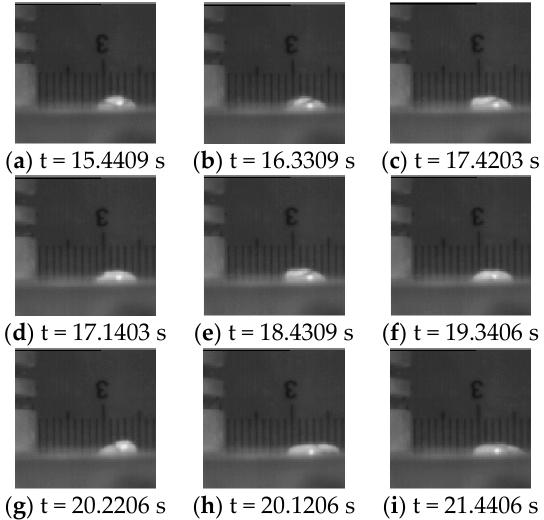
Figure 15. The movement characteristics of droplet under DC positive polar power source. ( a ) droplet without applied voltage ( b ) droplet begin to add voltage ( c ) droplet with voltage of 10 kV.